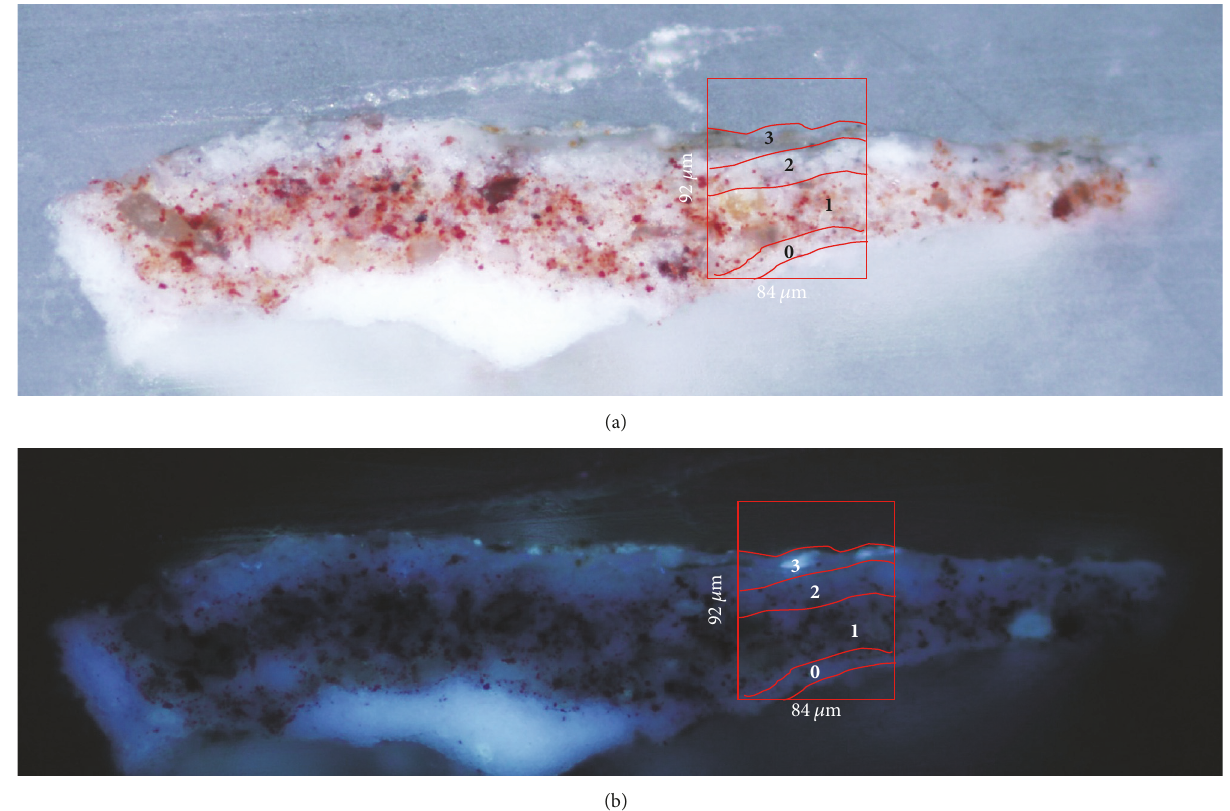
Figure 5: Cross-section microphotographs of sample PO1 embedded in KBr. (a) image under visible light; (b) image under UV illumination. The red box indicates the selected area for 𝜇 FTIR-ATR